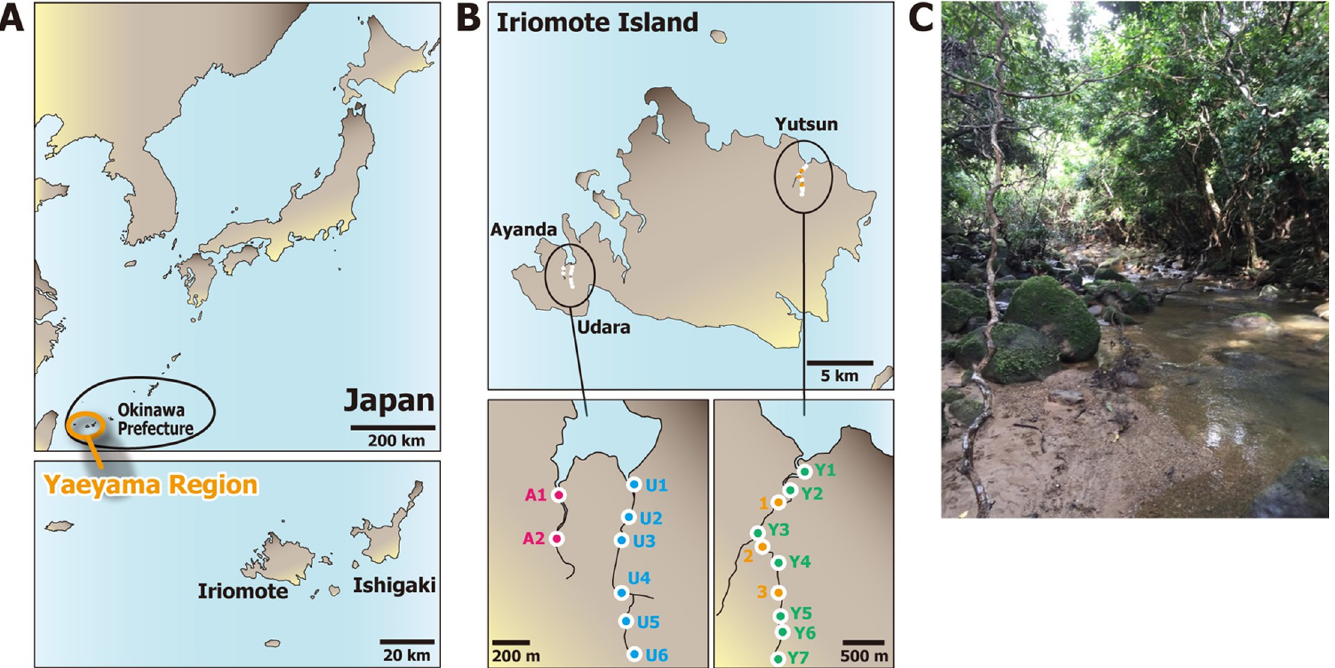
Fig 1. Yaeyama region and locations of soil and river water sampling sites. (A) Locations of Okinawa prefecture and Yaeyama region are shown in the upper left panel, and the Iriomote and Ishigaki Islands are shown in the lower-left panel. The ranges of Okinawa prefecture and Yaeyama region are approximate. (B) Sampling locations alongside of the Yutsun River or Udara and Ayanda Rivers on the east and west sides of the Iriomote Island, respectively. Soil sampling sites are indicated as 1 to 3 (orange circles), and river water sampling sites are as Y1 to Y7 (green circles), U1 to U6 (blue circles), and A1 and A2 (red circles) for Yutsun, Udara, and Ayanda, respectively. The geographical map was drawn by the author using Adobe Illustrator 2021 v25.2 on the basis of map images provided by Geospatial Information Authority of Japan (https://maps.gsi.go.jp) under CC BY 4.0 compatible license. (C) Picture of the representative trekking course along the Yutsun River, soil sampling site 2 (photo credit: Claudia